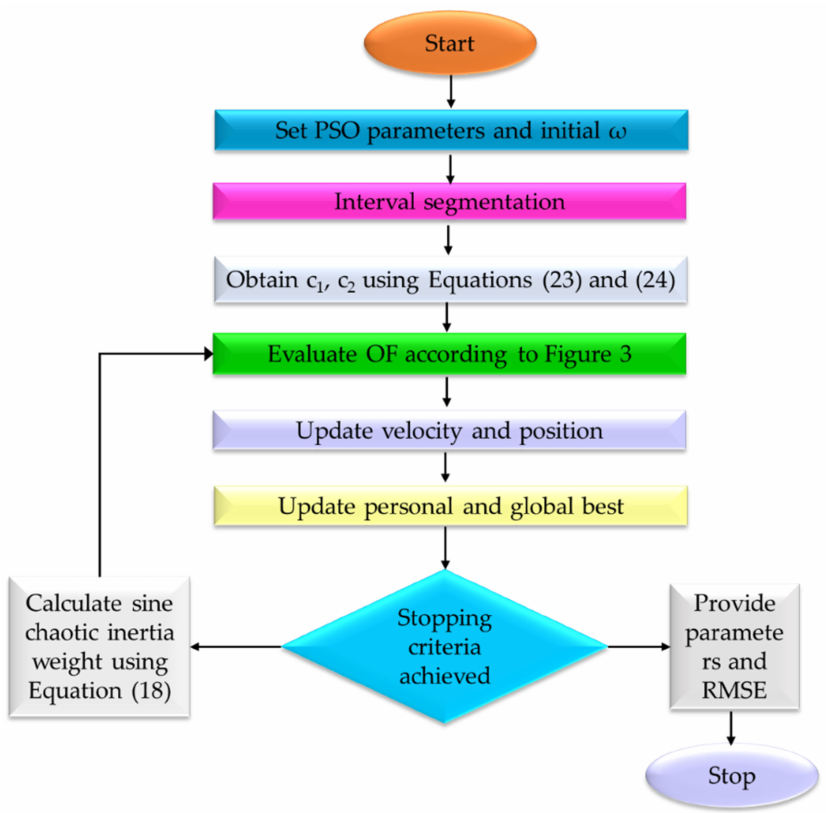
Figure 9. Flowchart of CIWPSO algorithm for parameter estimation of PV models (reprinted